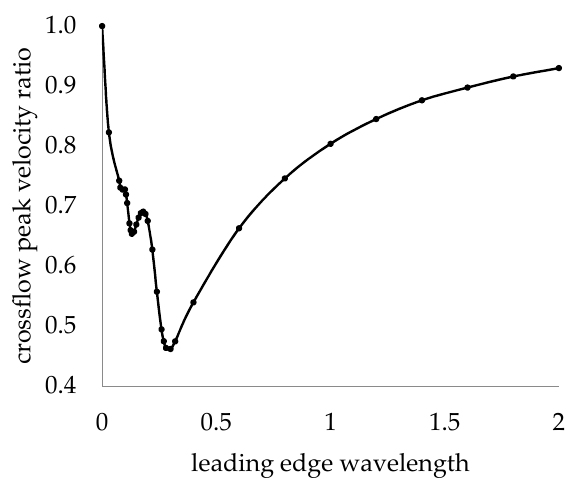
Figure 15. Velocity modification factors at the LE peak and 10% chord location. Straight leading-edge results are shown at zero wavelength.